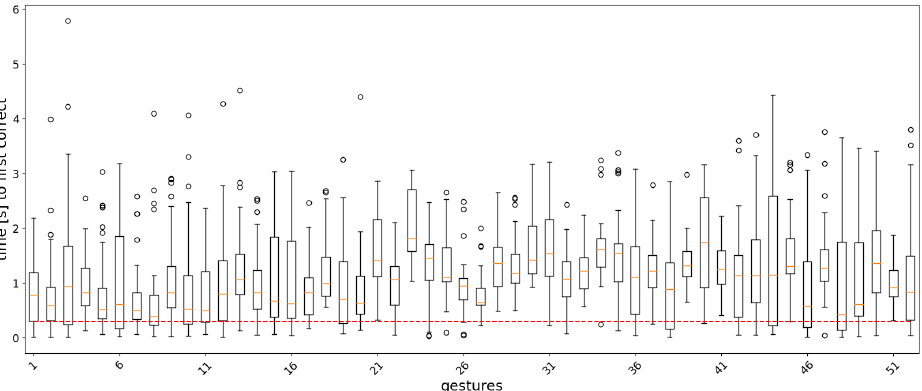
Figure 9. Boxplots of the distribution of the time to the first correct prediction per gesture for the Att2500 model. The boundaries of the boxes correspond to the Q1 and Q3 quartiles, the boundaries of the standard deviations are Q1 − 1.5IQR and Q3 + 1.5IQR, where IQR = Q3 − Q1, and the circles correspond to outliers. The red dashed line corresponds to 300